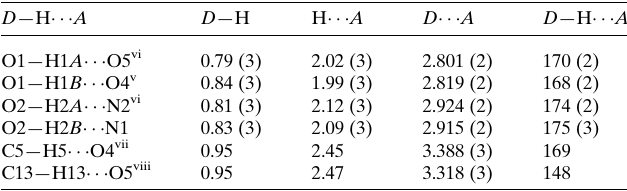
Table 1 Selected bond lengths (A˚ ).